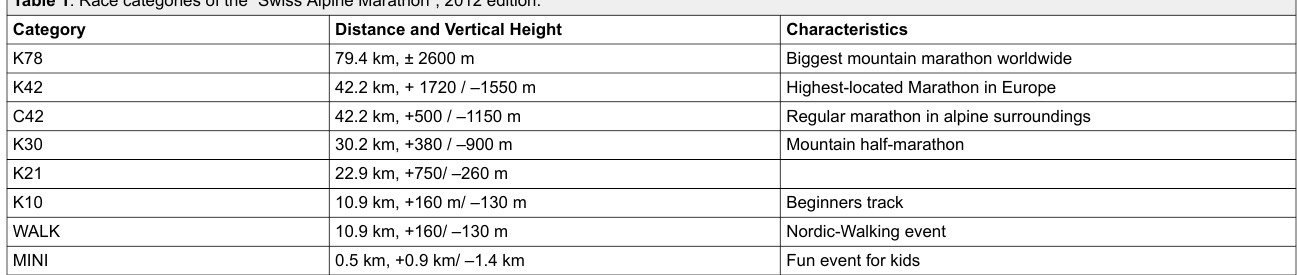
Table 1 : Race categories of the “Swiss Alpine Marathon”, 2012 edition.